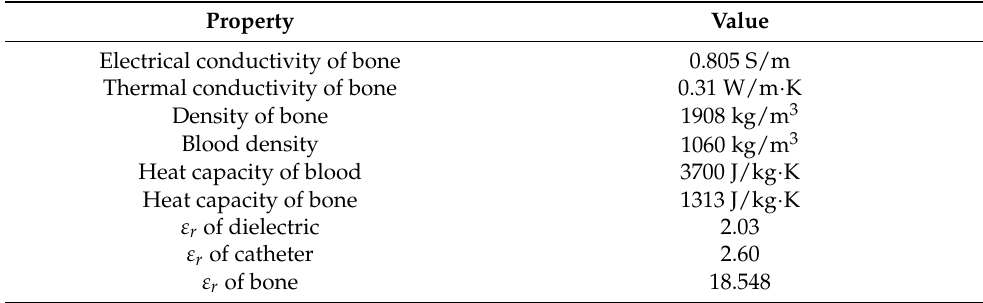
Table 1. Dielectric and thermal properties for analyzed electro-thermal model [43,49,50].